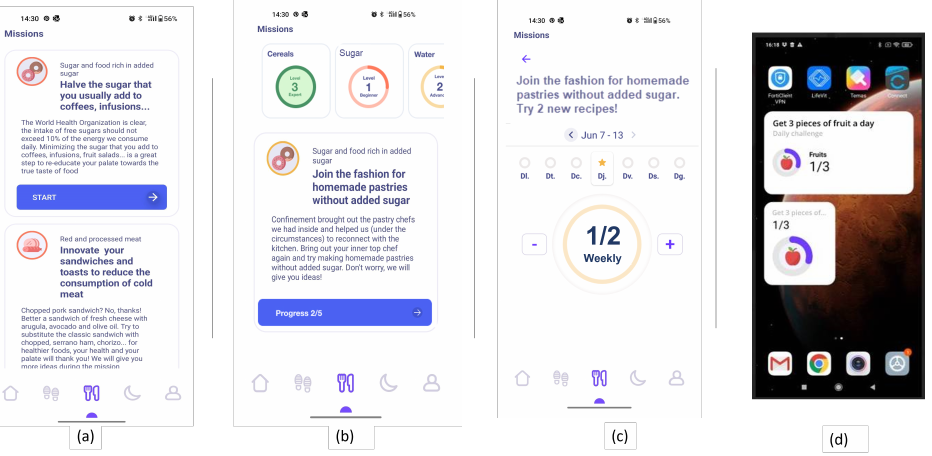
Figure 4. Screenshots from the CarpeDiem app showing missions interface. ( a ) List of missions